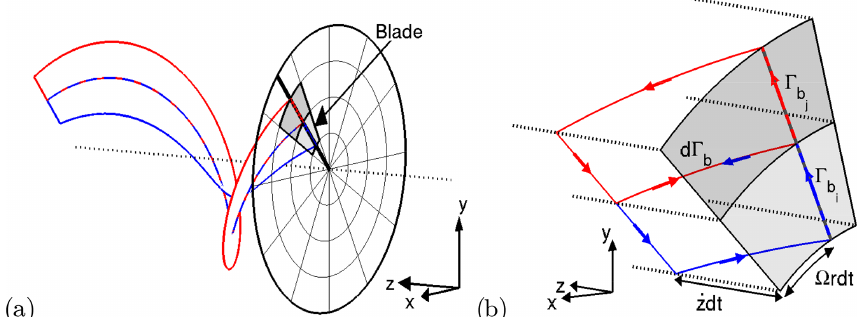
− (cid:48) b i in the radial direction. j